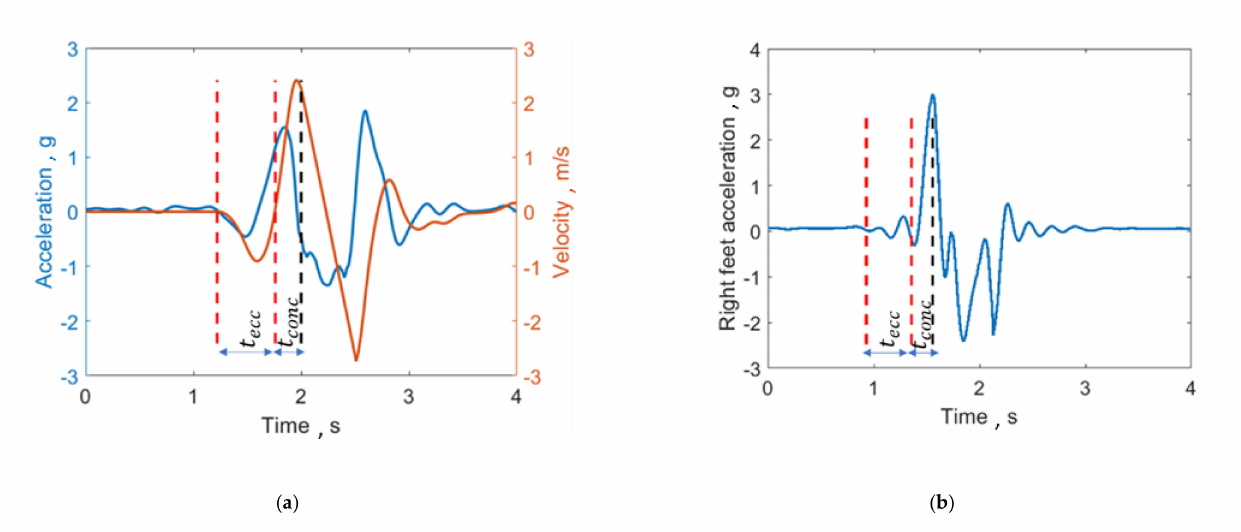
Figure 2. ( a ) Segmentation of the jump from acceleration and velocity of the body centre of mass. t ecc and t conc are the eccentric and concentric phases duration, respectively. The red dotted lines limit the eccentric phase of the jump, while the black one delimits the concentric phase. ( b ) Acceleration traces of the right foot, which is characterized by a peak in correspondence to the take off. The two negative peaks in the acceleration trace correspond to an extension movement of the foot immediately after the take off and before the landing, respectively. In particular, the first movement is the consequence of the boost phase that precedes the take-off, while the second one is an anticipatory movement carried out by the athlete for better landing on the